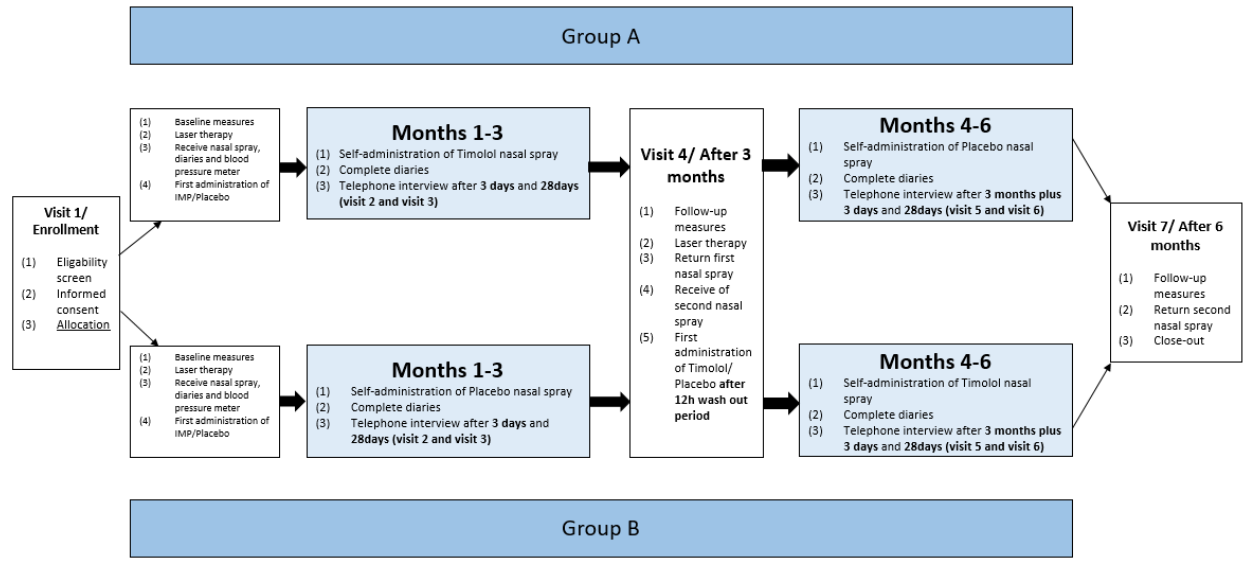
Figure 1. Flowchart of the study schedule.